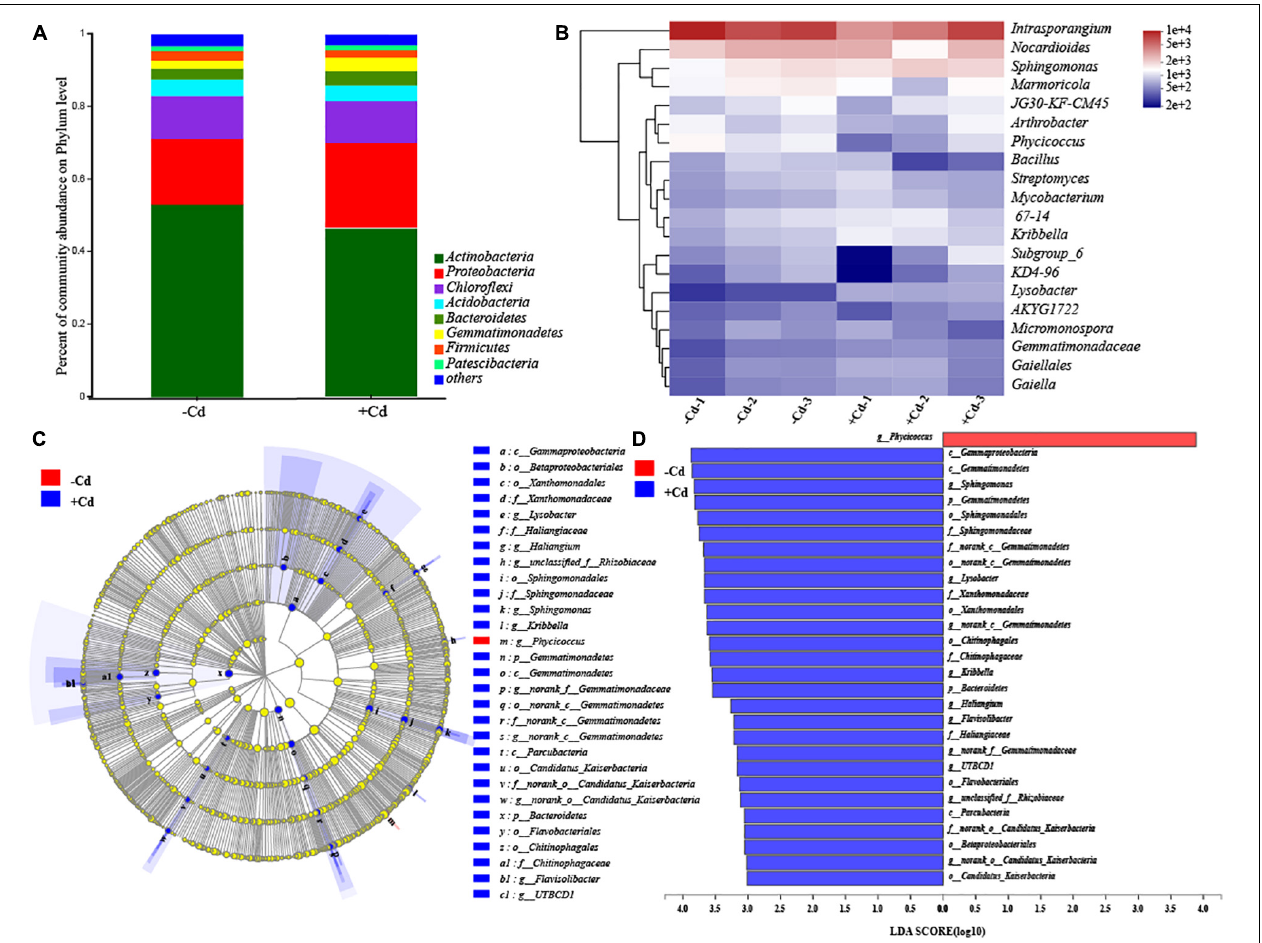
FIGURE 2 | Comparison of bacterial communities in –Cd and + Cd samples. Changes in microbial community on phylum level (A) . Heatmap showing changes in microbial community on genus level (B) . Cladogram showing the phylogenetic distribution of the bacterial lineages in + Cd and –Cd samples (C) . Indicator bacteria with the linear discriminant analysis scores of 3 or greater in bacterial communities in + Cd and –Cd samples (D) . Different-colored regions represent different treatments. Circles indicate phylogenetic levels from phylum to genus. The diameter of each circle is proportional to the abundance of the group. p, phylum; o, order; c, class; f, family; g,